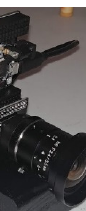
Figure 3. Numato STYX FPGA Board with a ZYNQ XCZ7020 SoC and an OV5642 Camera and lens.